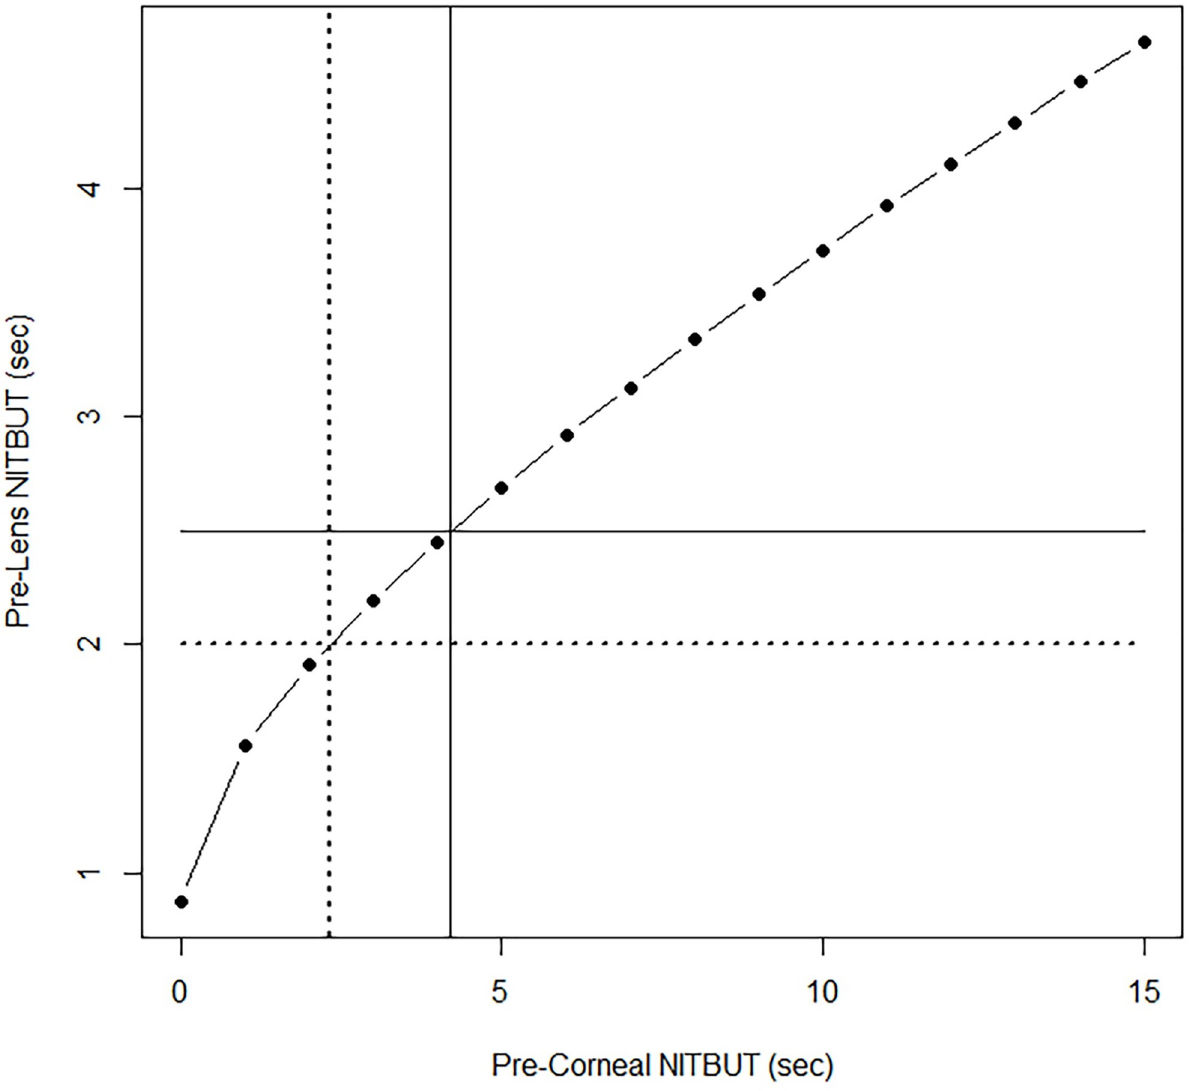
Fig 3. Model estimates for pre-lens NITBUT at 10 min post-contact lens insertion. Crosshairs highlight the pre-corneal NITBUT at dryness symptom-associated thresholds of pre-lens NITBUT ( < 2.5 sec for any symptoms, < 2.0 sec for severe symptoms). For these pre-lens thresholds, the associated pre-corneal values are 4.20 sec and 2.31 sec,